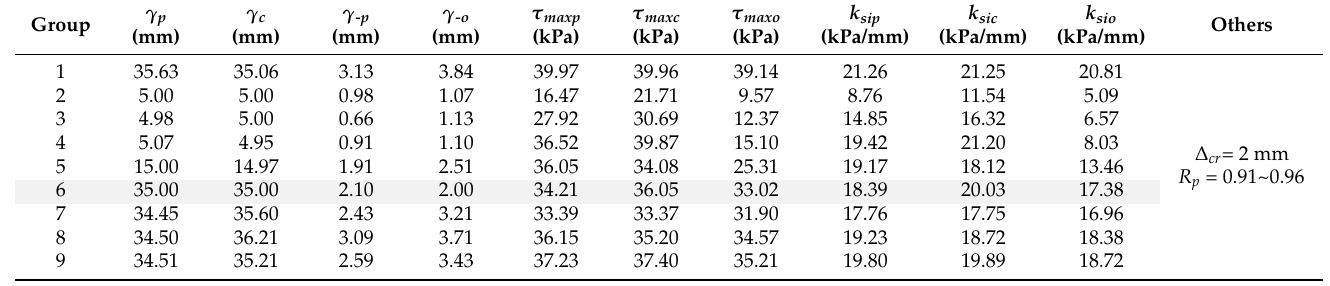
Table 5. The displacement parameters and stress parameters.